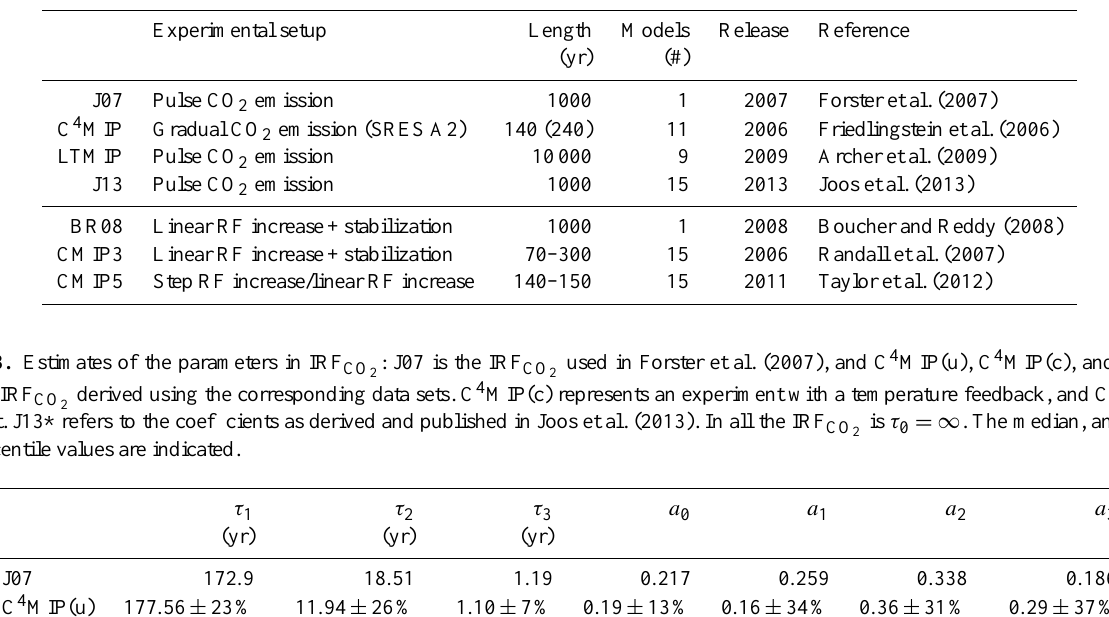
and IRF T . The number of models used here might be lower than the 2